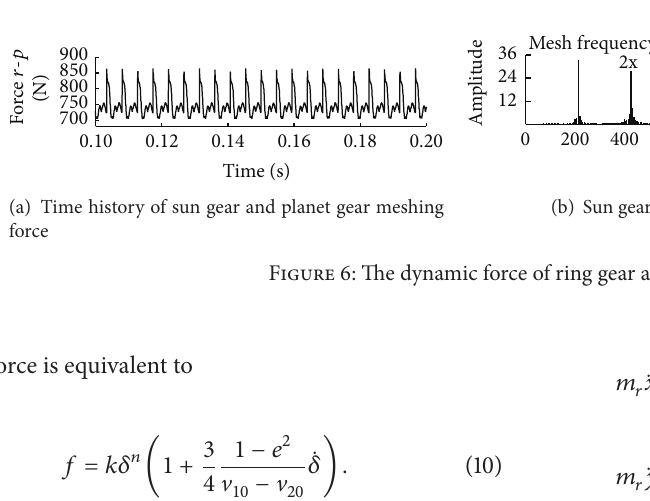
Figure 5: The dynamic force of sun gear and planet gear.